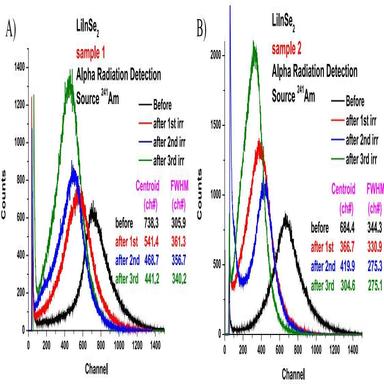
Alpha radiation decay time measured of the two samples before and after each irradiation.